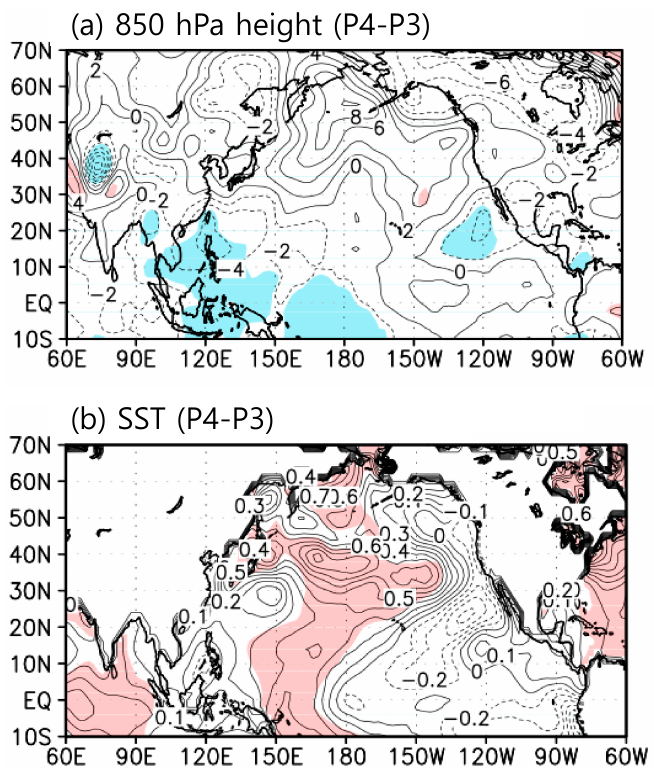
Figure 8. Composite differences of summertime ( a ) geopotential height at 850 hPa (Unit: gpm), ( b ) sea surface temperature (Unit: °C) of the periods P4 and P3. The values in the shaded areas are significant at the 90% confidence level with the Student’s t -test.